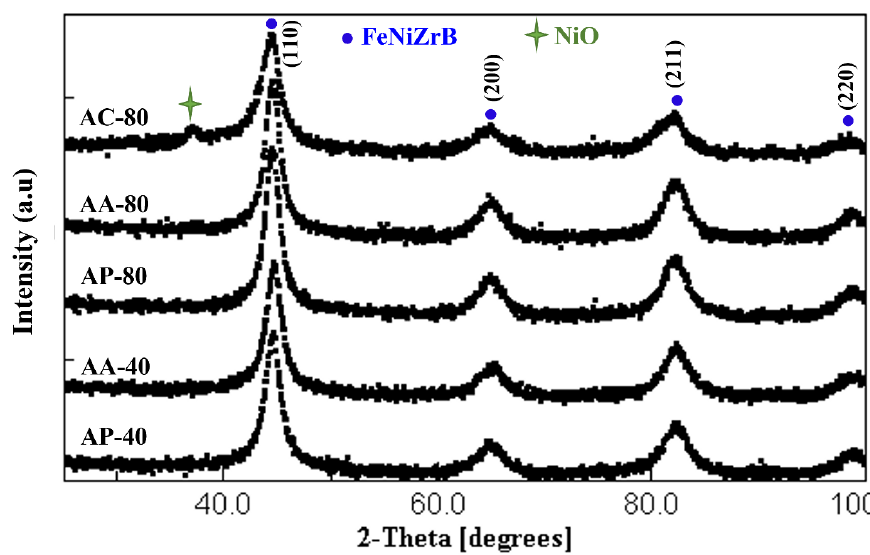
Figure 3. XRD diffractograms for samples of A alloy (Fe 80 (NiZr) 8 B 12 ).